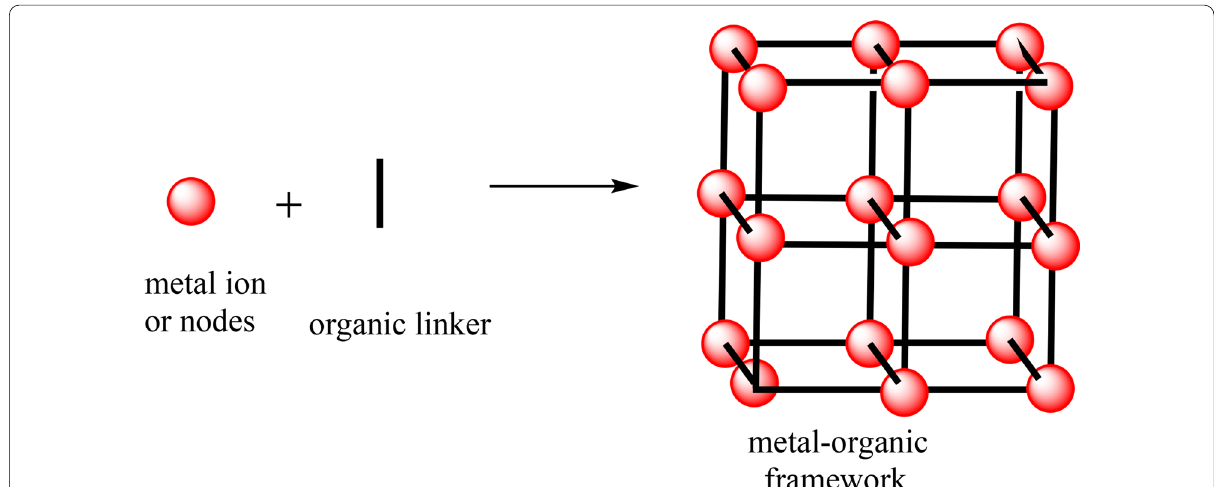
Fig. 1 Illustration of MOF’s building blocks and resulting porous, crystalline